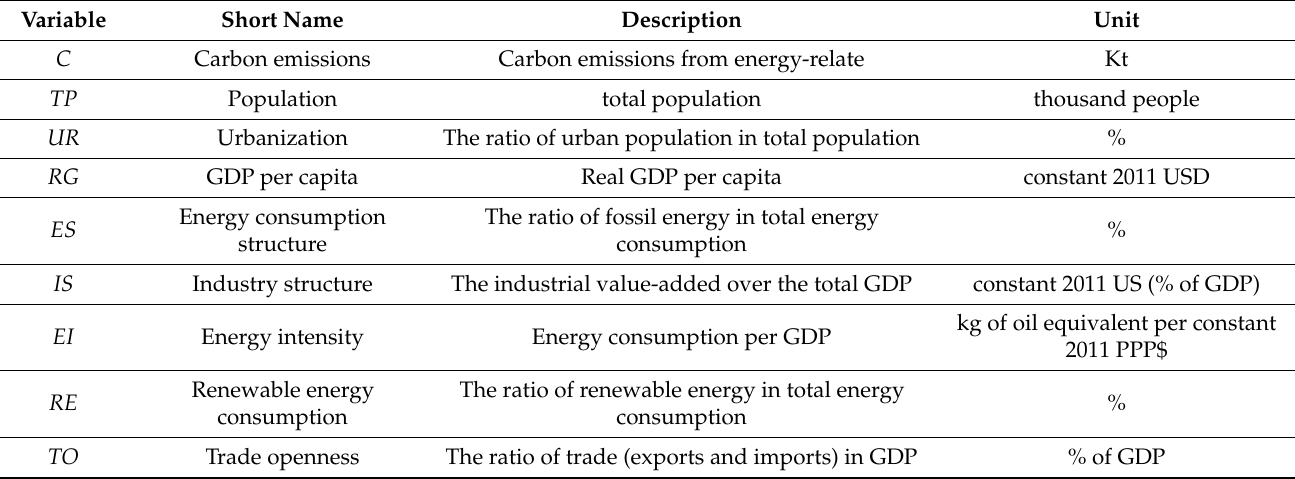
Table 2. The detailed driving factors in the STIRPAT